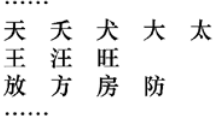
(sky).” As the word “ (today)” includes one